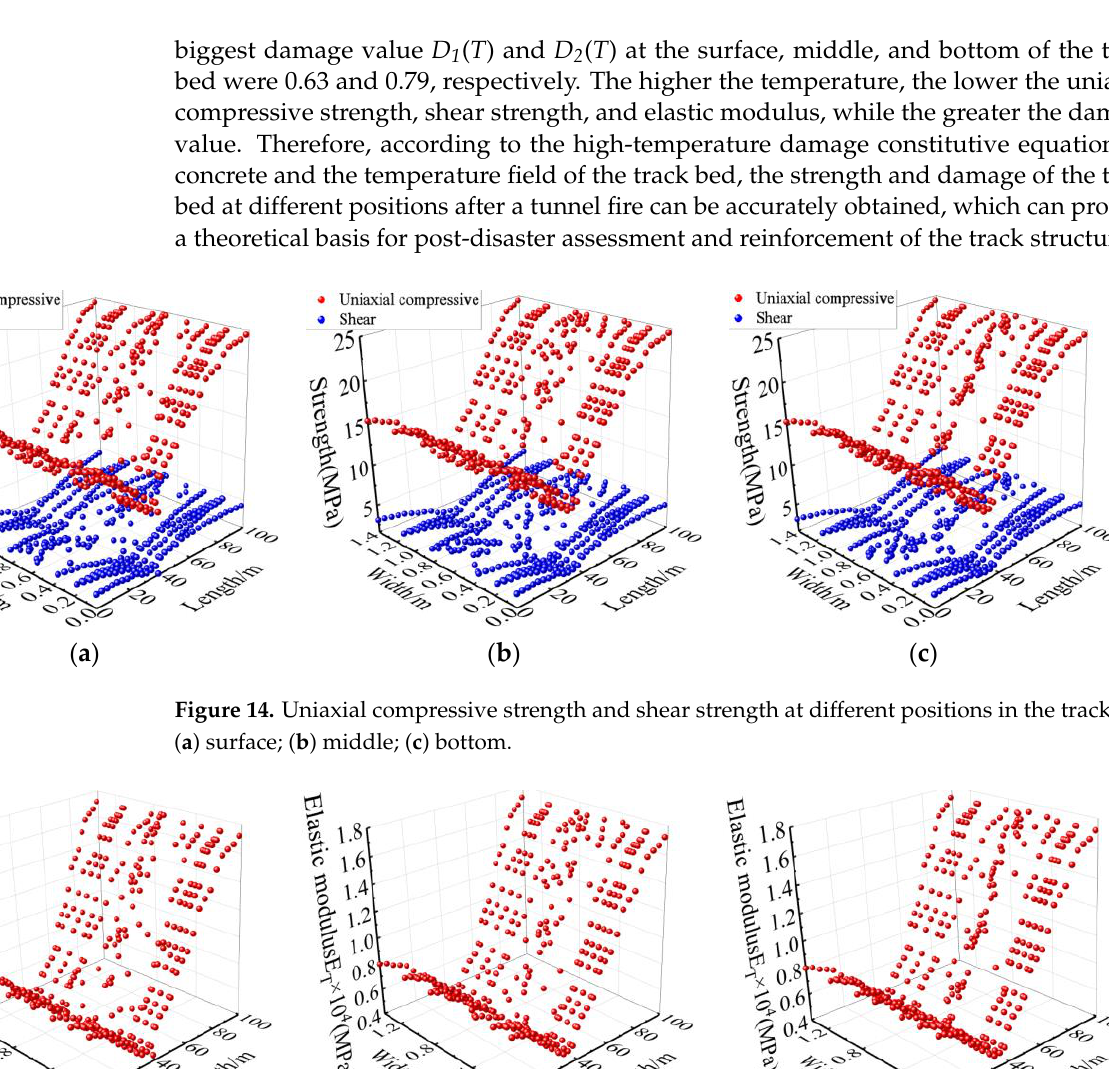
Figure 13. Temperature at different positions in the track bed: ( a ) surface; ( b ) middle; ( c ) bottom.